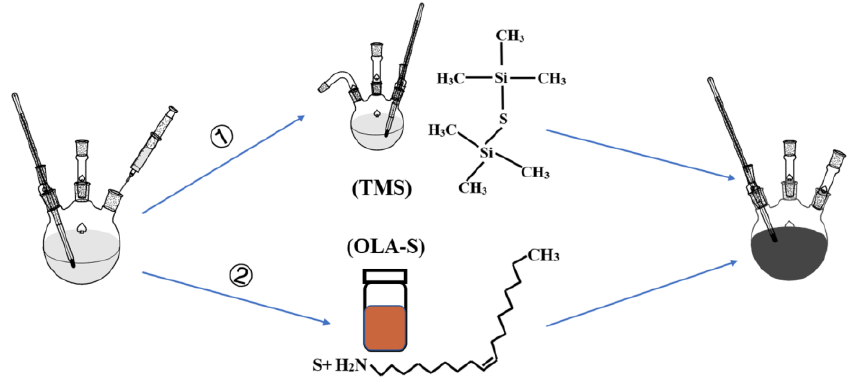
Figure 1. Synthetic route for colloidal AgBiS 2 NCs using different sulfur sources (path 1: TMS, path 2: OLA – S). path 2: